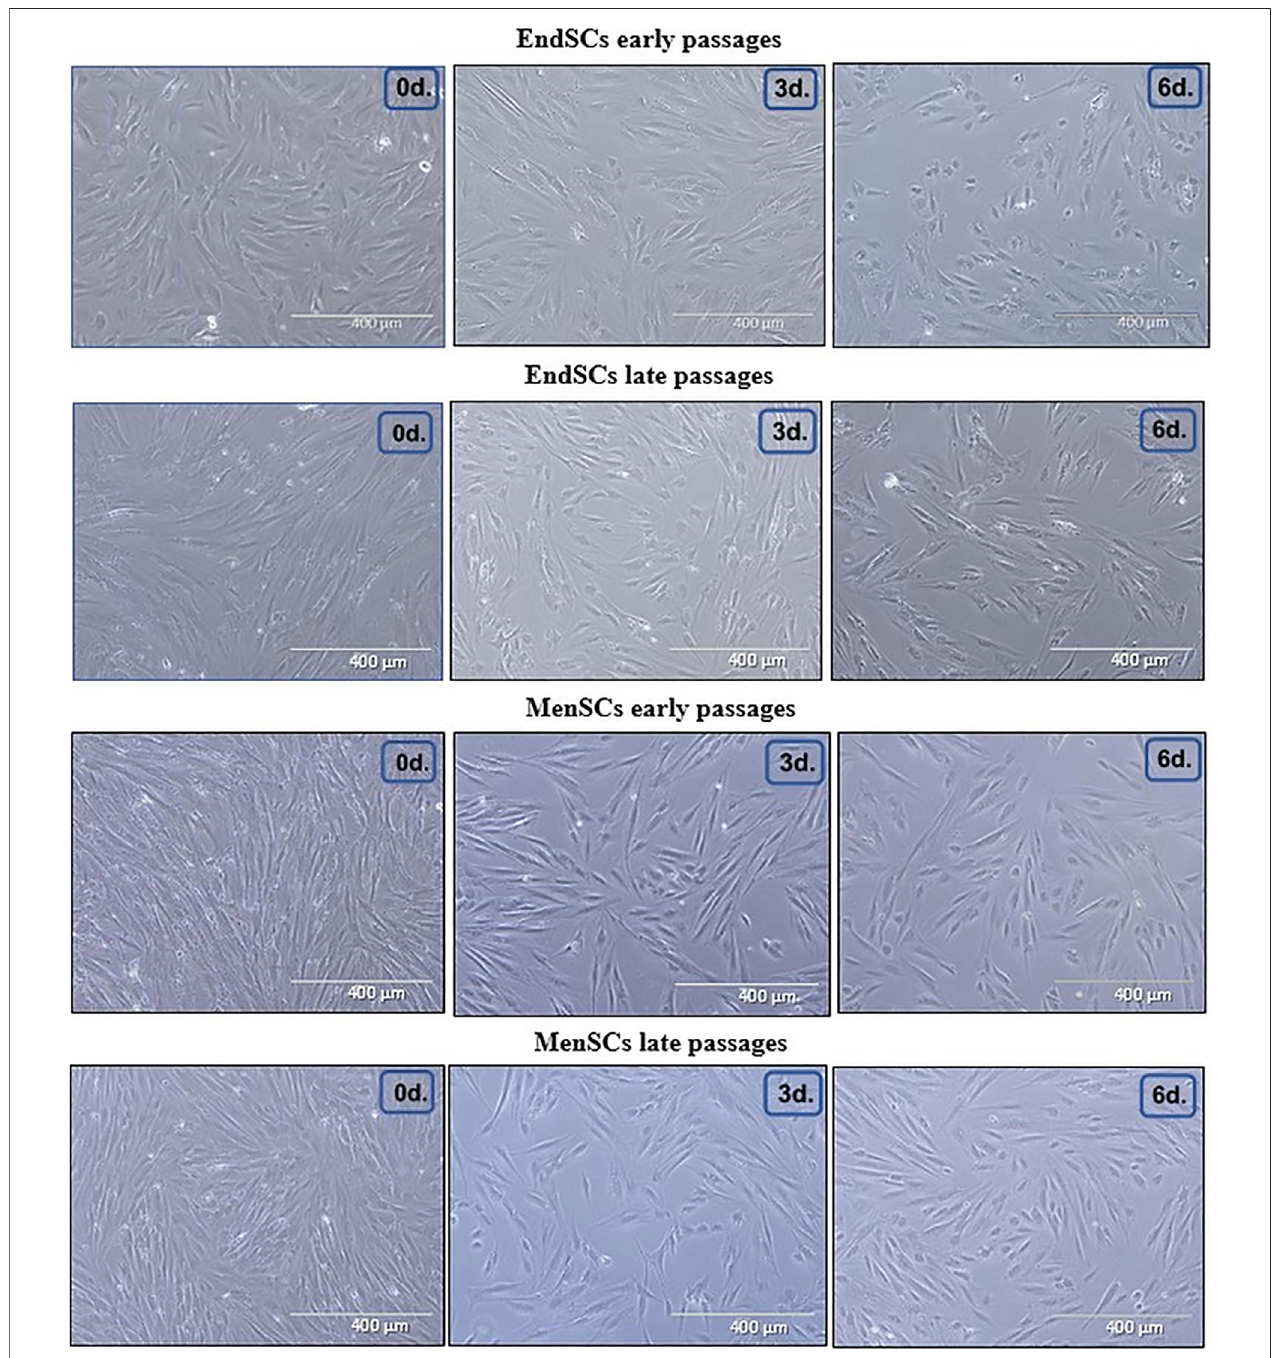
FIGURE6| Morphological characterizationofEndSCs and MenSCs during decidualization. Morphologicalalterations were evaluated inearly and late passages of EndSCs and MenSCs after 3 and 6 days of decidualization. 0d. — undifferentiated control cells, 3d. — cells after 3 days of decidualization, 6d. — cells after 6 days of decidualization. Scale bar (cid:2) 400